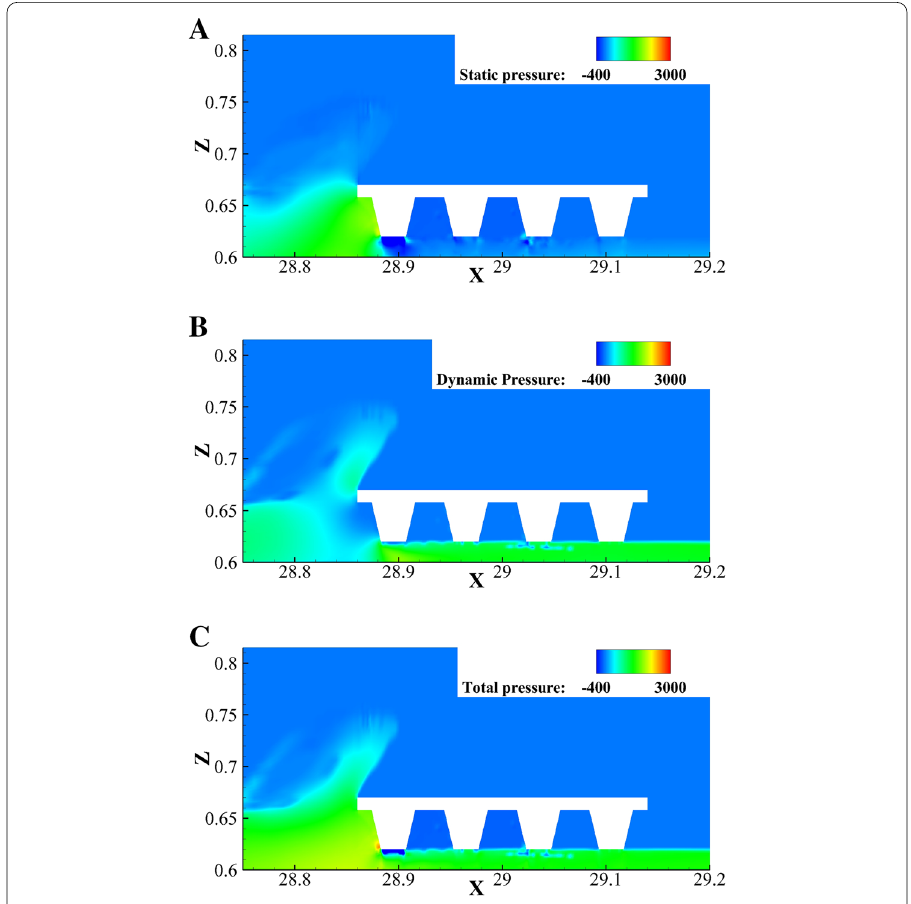
Fig. 16 Static pressure ( a ), dynamic pressure ( b ) and total pressure ( c ) at t pressure: